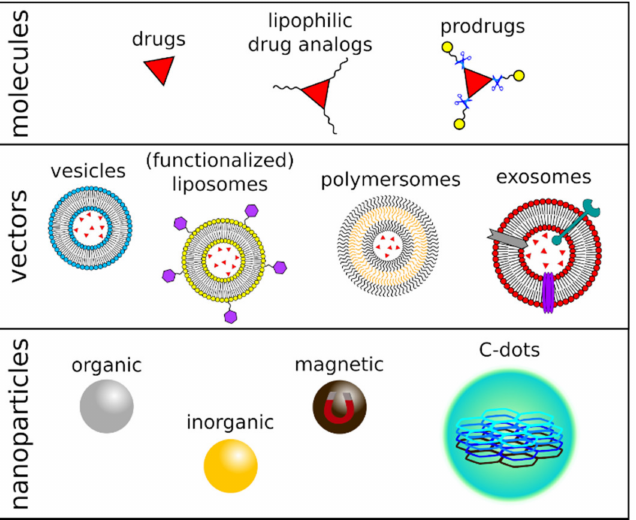
Figure 1. Figurative representation of chemical-, vector-, or nanomaterial-based drug delivery